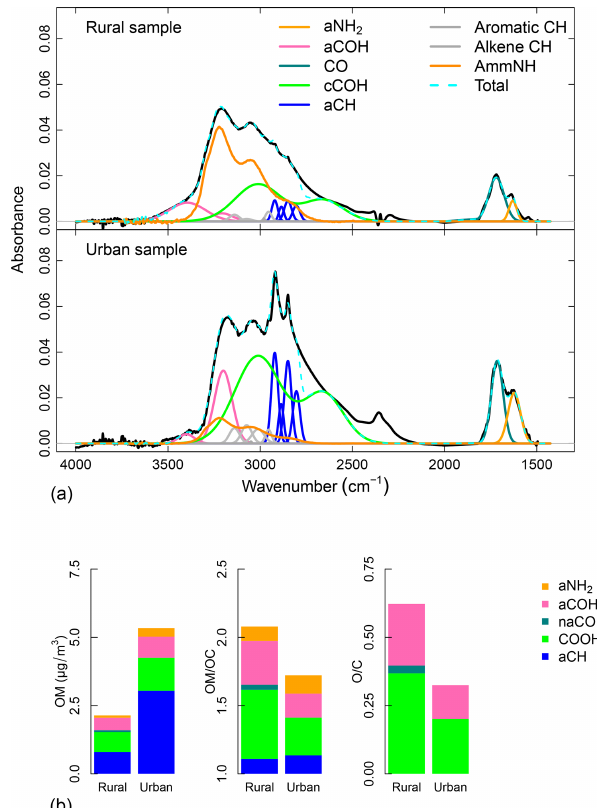
Figure 5. Peak-fitting package outputs. Example of FG analysis by FT-IR spectroscopy of atmospheric aerosol collected on one Teflon filter. (a) Baseline-corrected spectra (black lines) with fitted FGs (colored lines) for the rural (top panel) and urban (bottom panel) samples. (b) From left to right the bar plots represent the FG con- tributions to total OM, their non-carbon contributions to the total OM / OC ratio (Takahama and Ruggeri, 2017), and the O / C atomic ratio for rural and urban